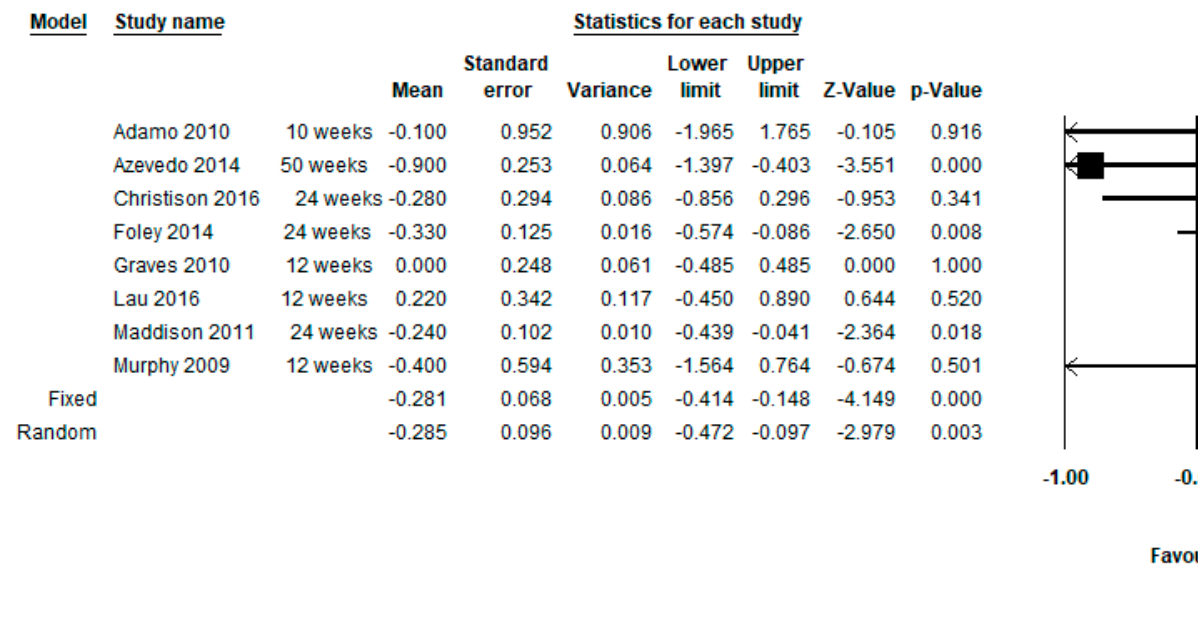
Figure 9. Pre-post difference of BMI between groups. Only BMI (Kgr/m 2 ) in the longest follow-up.